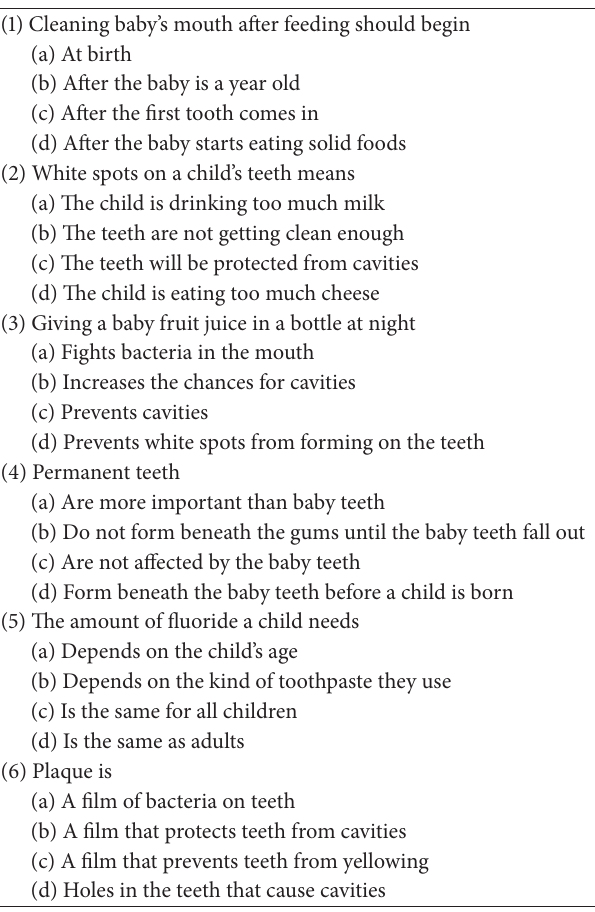
Table 3: Sample pre- and posttest knowledge questions—multiple choice, 21 items